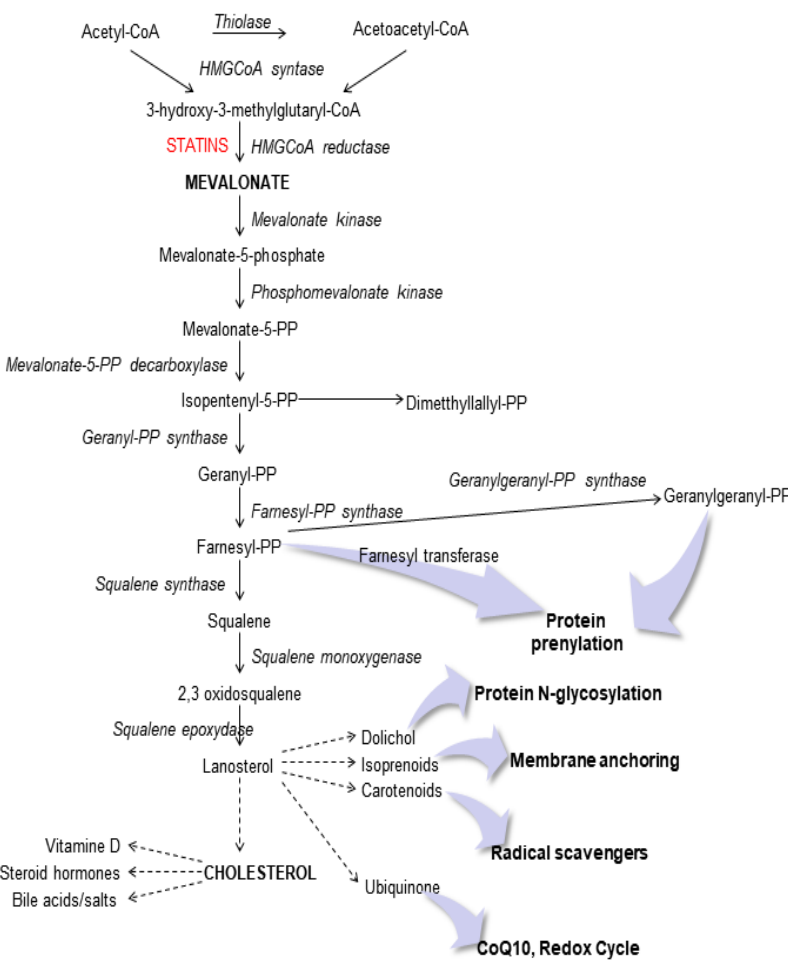
Figure 1. Schematic representation of the mevalonate pathway.